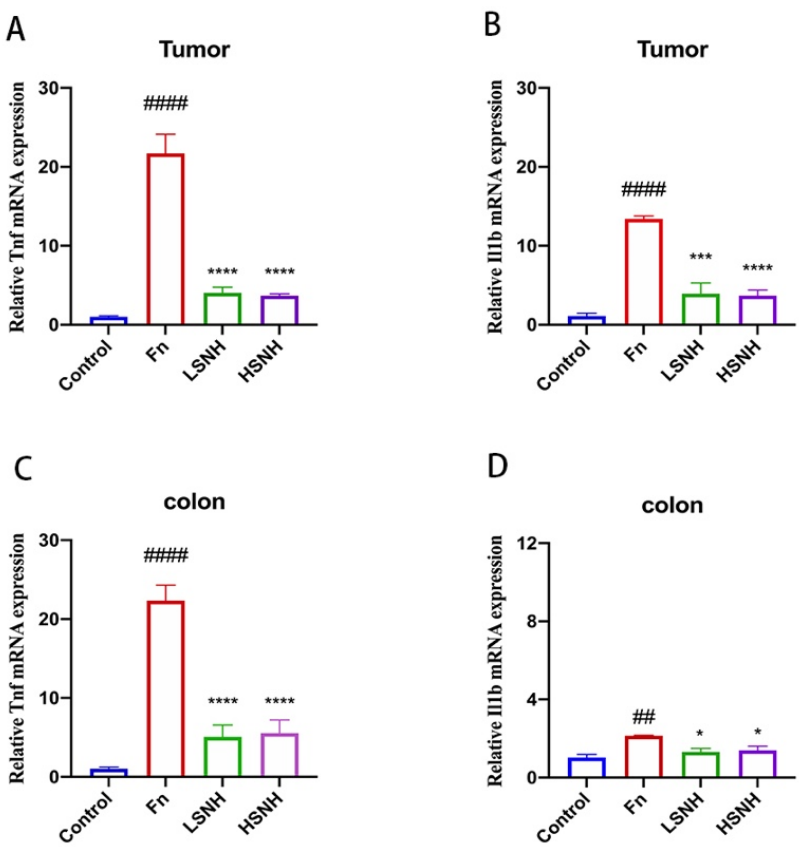
Figure 8. Alleviation of Fn -induced tumors growth and inflammatory response by SNH treatment. ( A – D ), qPCR analysis of the expression of genes encoding the proinflammatory cytokines TNF- α ( A , C ) and IL-1 β ( B , D ) in the tumors and the colon tissues of the HCT116-engrafted mice with Fn colonization. All values were represented as mean ± SD, and p values < 0.05 were considered statistically significant. * p < 0.05, *** p < 0.001, **** p < 0.0001, vs. Fn group. ## p < 0.01, #### p < 0.0001, vs. Control.